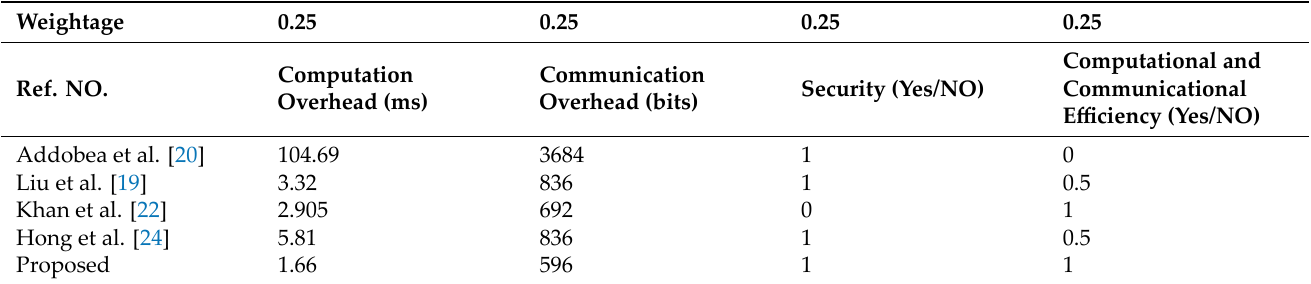
Table 10. Performance metrics of the suggested